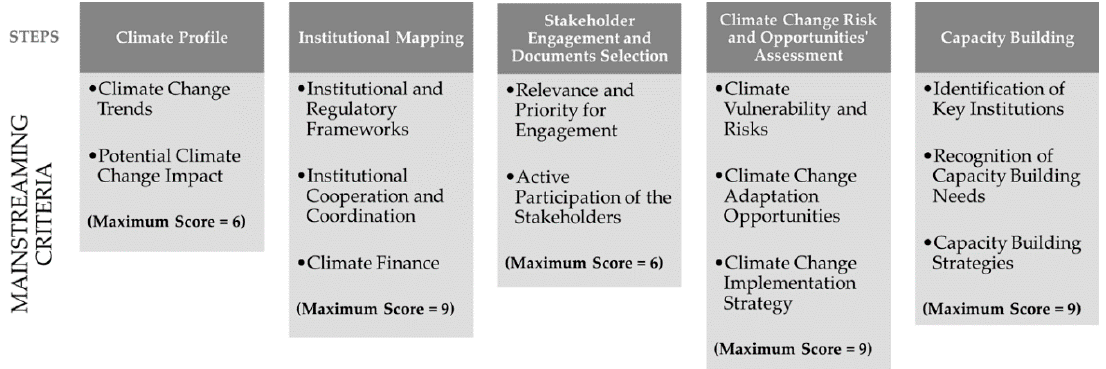
Figure 2. Analytical framework for the quantitative content analysis.